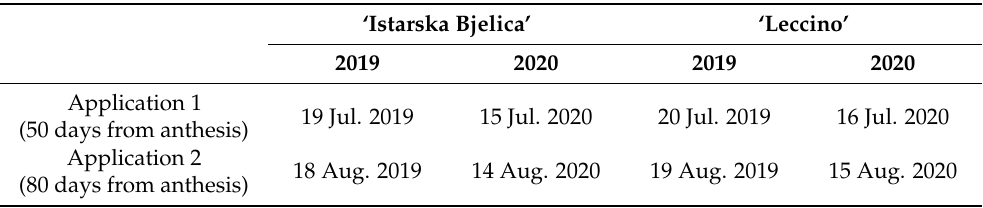
Table 1. Foliar fertilization with sulfur and nitrogen in 2019 and 2020. ‘Istarska Bjelica’ ‘Leccino’